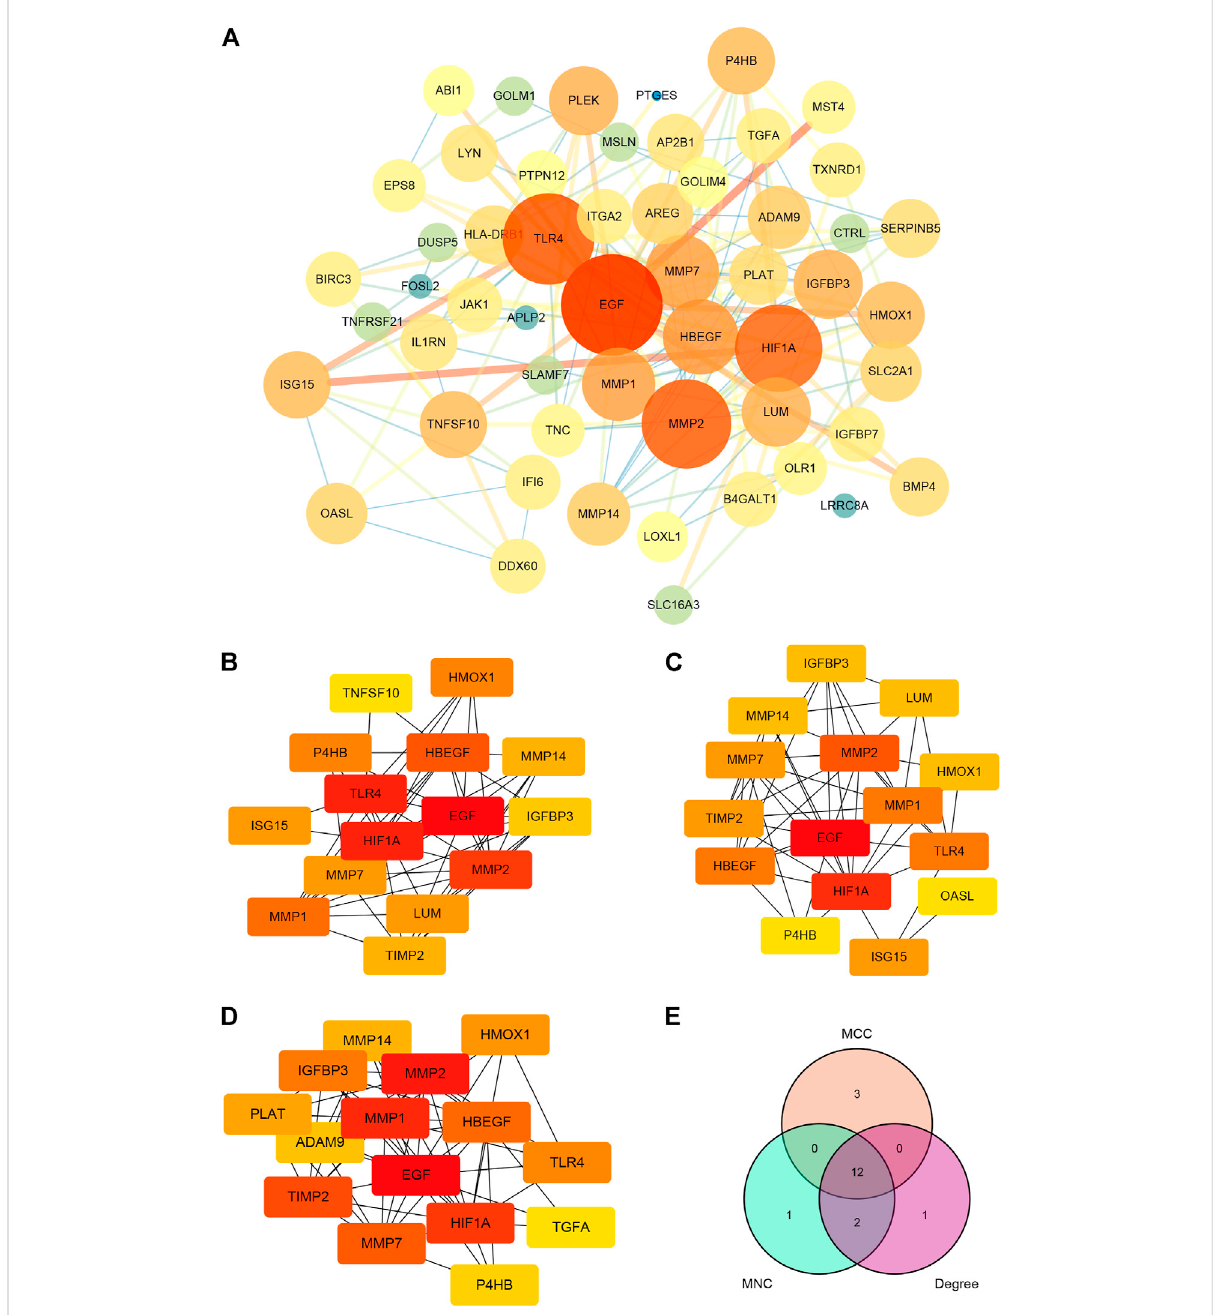
FIGURE 5 PPI network construction and hub genes screening. (A) PPI network of paeoni fl orin for treating pancreatic cancer. The greater the number of linkednodes,thelargeranddarkerthecircleanditscolor.Threescreeningtechniquesforhubgenes(implementedbytheCytohubbaplugin).Yellow nodeshavethelowestcorrelationstrength,whereasrednodeshavethegreatest. (B) MCC; (C) MNC; (D) DEGREE. (E) AVenndiagramanalysisofhub gene screening using Cytohubba. Each hue corresponds to a screening algorithm. The core gene is the hub gene, which is the gene present in all fi ve